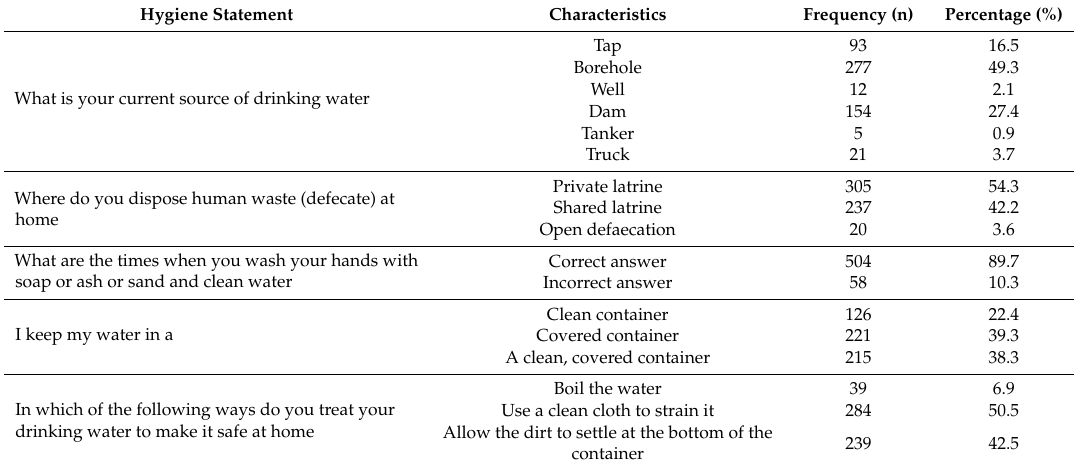
Table 5. Hygiene distribution of respondents (n = 562).